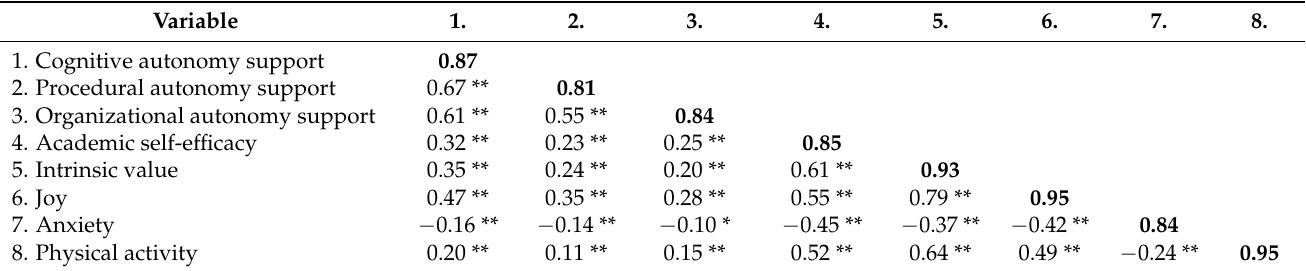
Table 1. Correlations between latent variables and composite reliability coefficients.